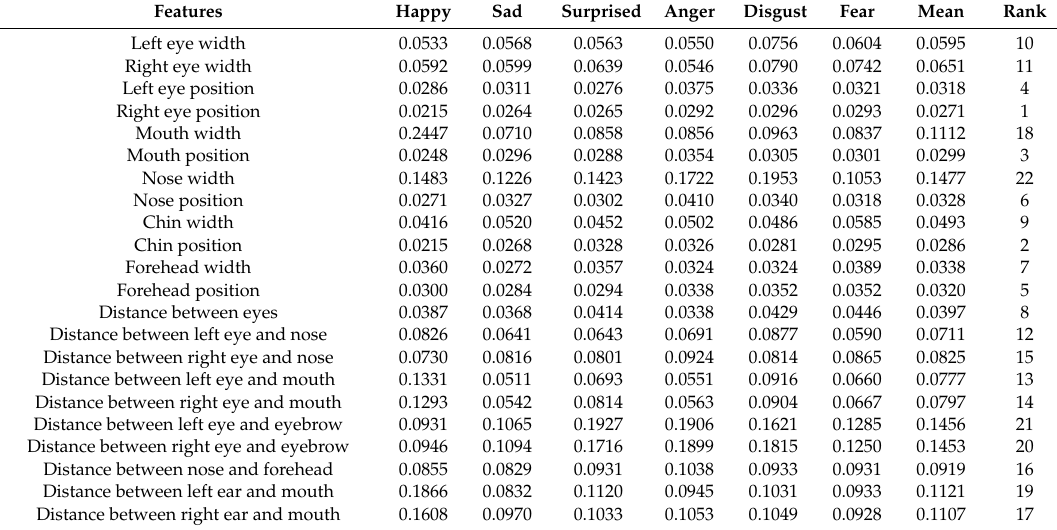
Table 12. The SS with respect to all expressions using all 22 features, top five, top ten, worst ten.